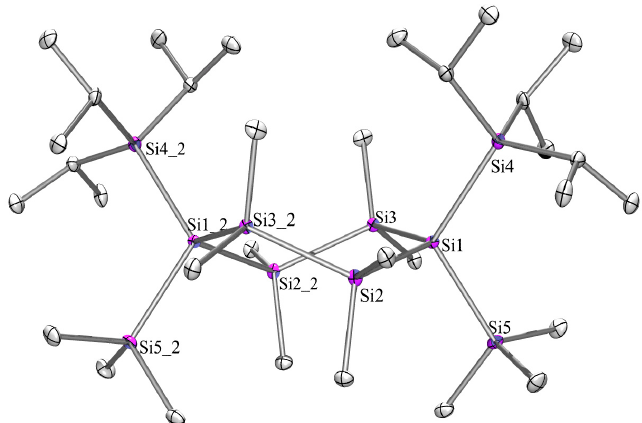
Figure 18. Crystal structure of 21a . Thermal ellipsoids are represented at the 30% level and hydrogen atoms have been omitted for clarity (bond lengths in Å, angles in deg). Si(1)-Si(5) 2.380(2), Si(1)-Si(3) 2.381(2), Si(1)-Si(2) 2.382(2), Si(1)-Si(4) 2.408(2), Si(2)-C(2) 1.882(6), Si(5)-Si(1)-Si(3) 105.57(7), Si(5)-Si(1)-Si(2) 104.19(8), Si(3)-Si(1)-Si(2) 106.93(7), Si(5)-Si(1)-Si(4) 113.14(8), Si(3)-Si(1)-Si(4) 112.16(8), Si(2)-Si(1)-Si(4) 114.13(8).